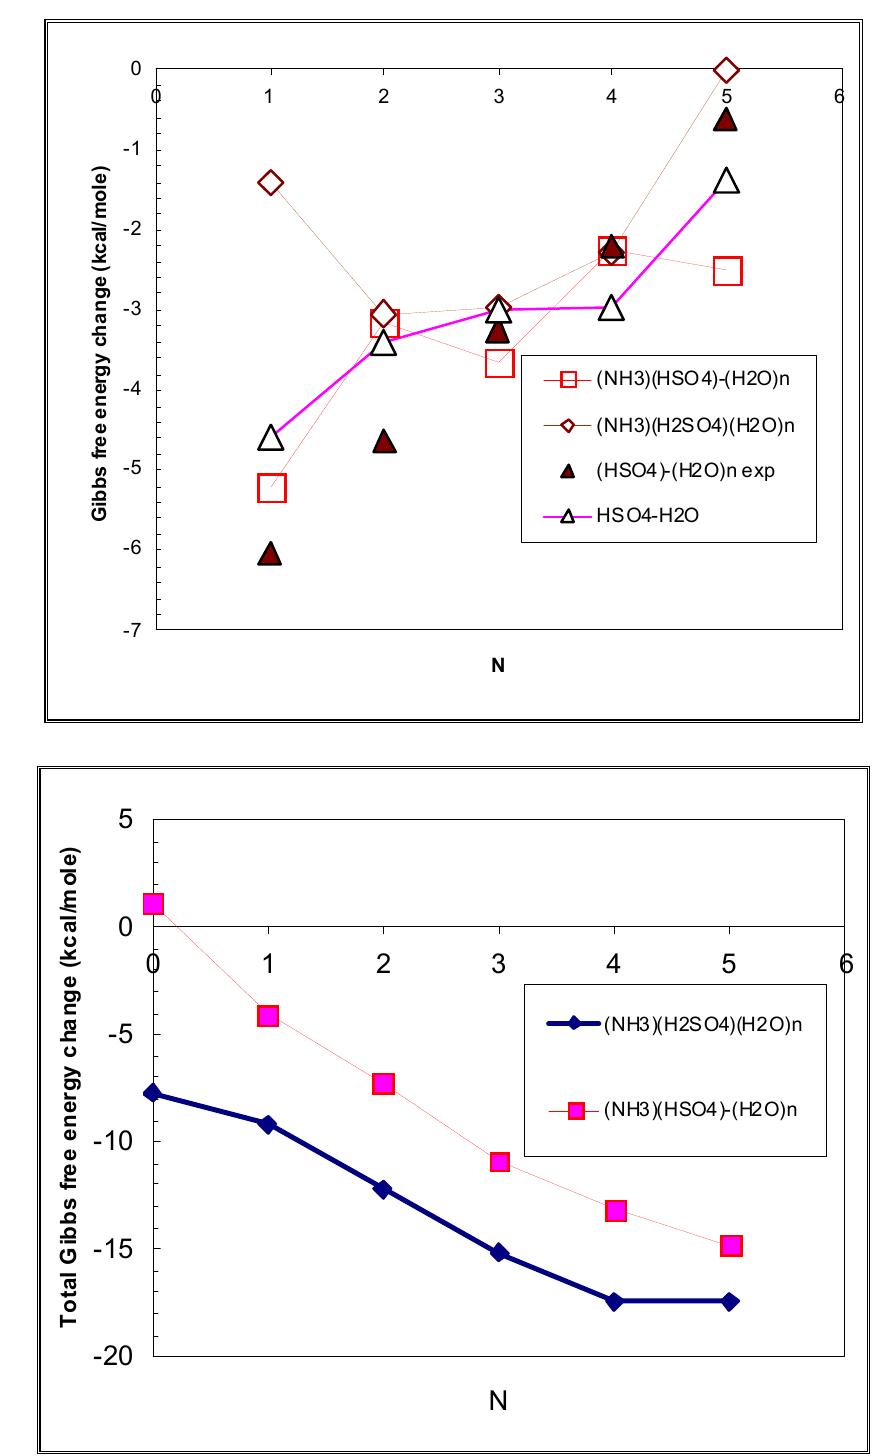
Figure 2 . The comparison of: (a) the stepwise Gibbs free energy changes associated with O) [35] , (H SO )(NH )(H O) [21] and (HSO 4- )(NH )(H O) the hydration of (HSO 4- )(H 2 n. 2 4 3 2 n 3 2 n (present study) and (b) total free energies associated with the formation of (H SO )(NH )(H O) [21] and (HSO 4- )(NH )(H O) from (H SO ), (NH ) and water 2 4 3 2 n 3 2 n 2 4 3 molecules and (H O) and (HSO 4- ), (NH ) and water molecules, respectively. T = 298.15 K 2 n 3 and P = 101.3 KPa. Subscript “exp.” refers to